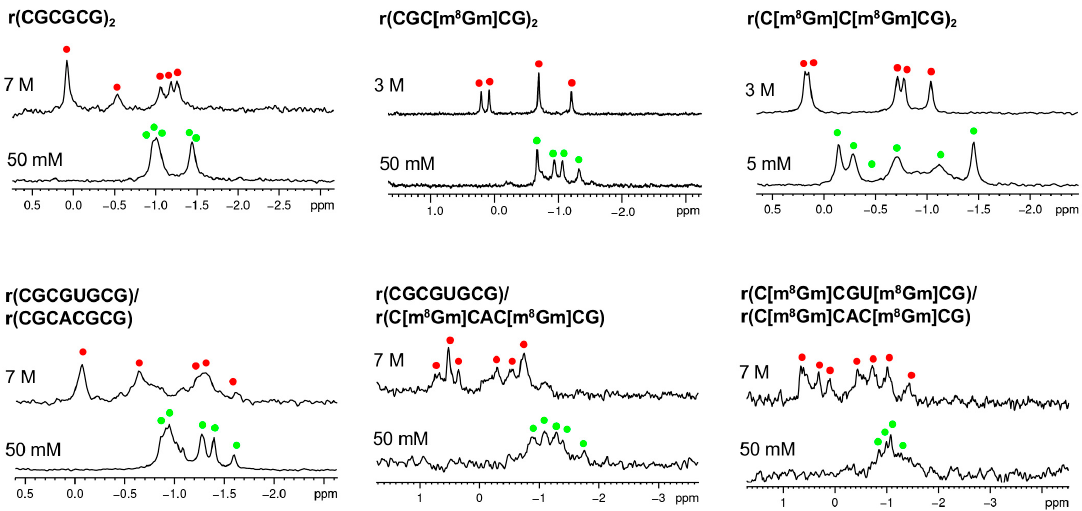
Figure 4. Monitoring of the A to Z-RNA transition by 31 P NMR. 31 P NMR spectra of the RNAs at 5 mM-7 M NaClO 4 . Green and red dots indicate the 31 P peaks resulting from A-RNA and Z-RNA, respectively.